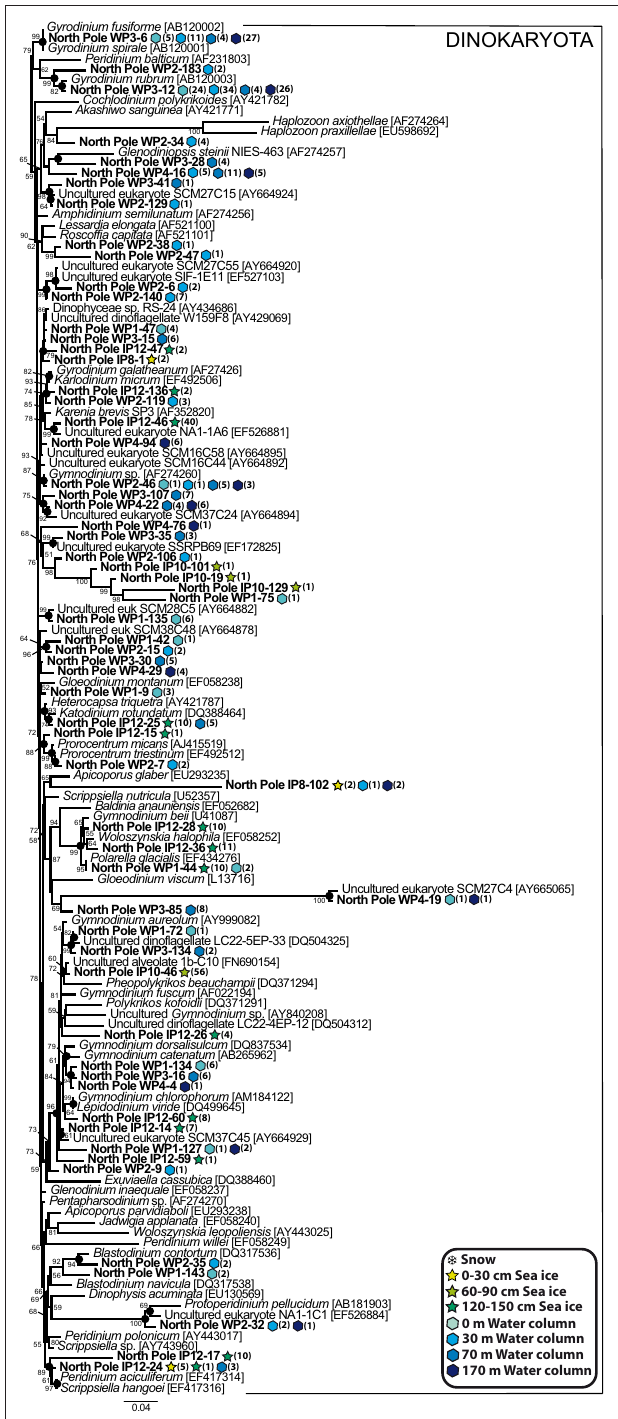
Figure 6 | Maximum likelihood phylogenetic tree of core dinoflagellate phylotypes. The tree was rooted with perkinsozoan sequences (not shown).